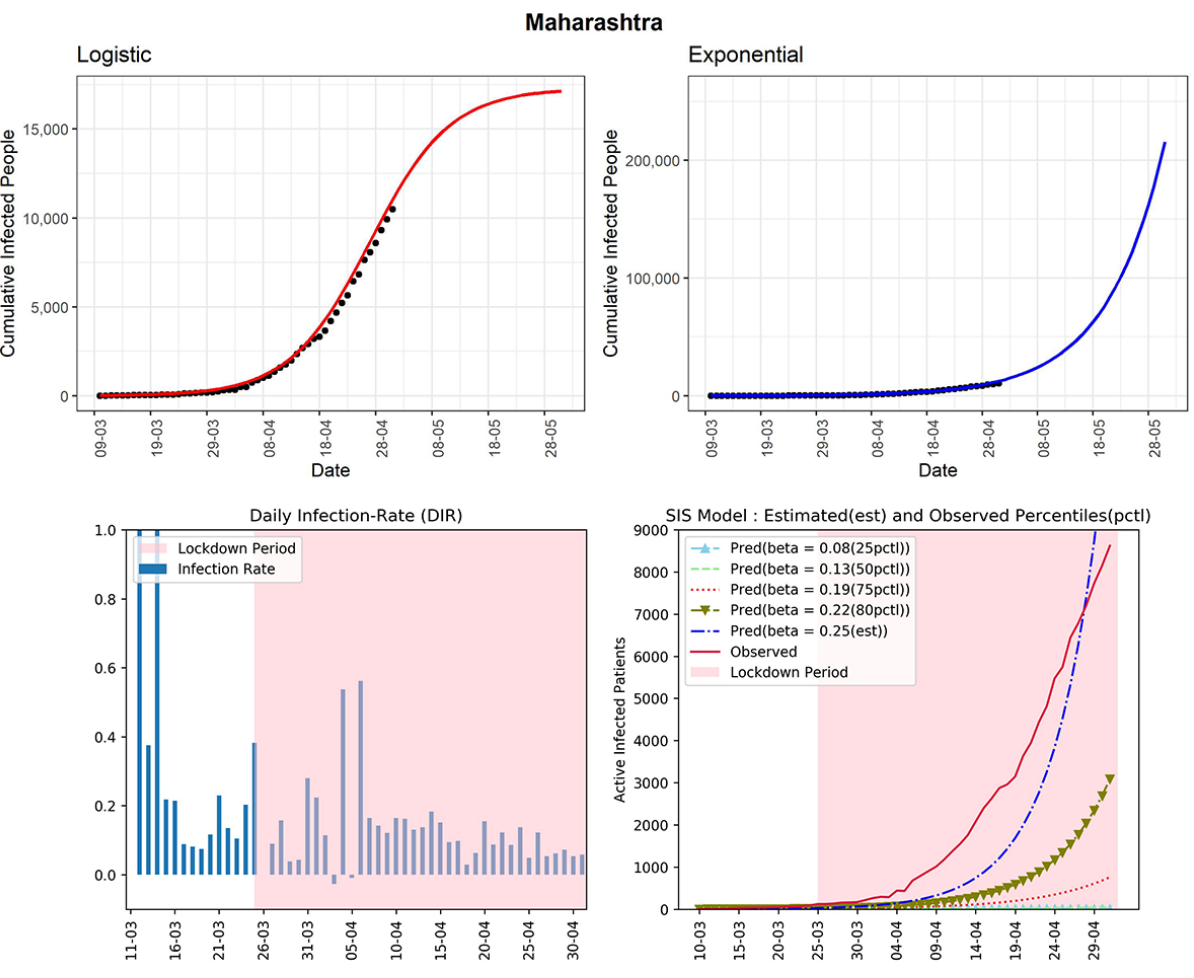
Figure 4. Graphs for the state of Maharashtra. SIS: